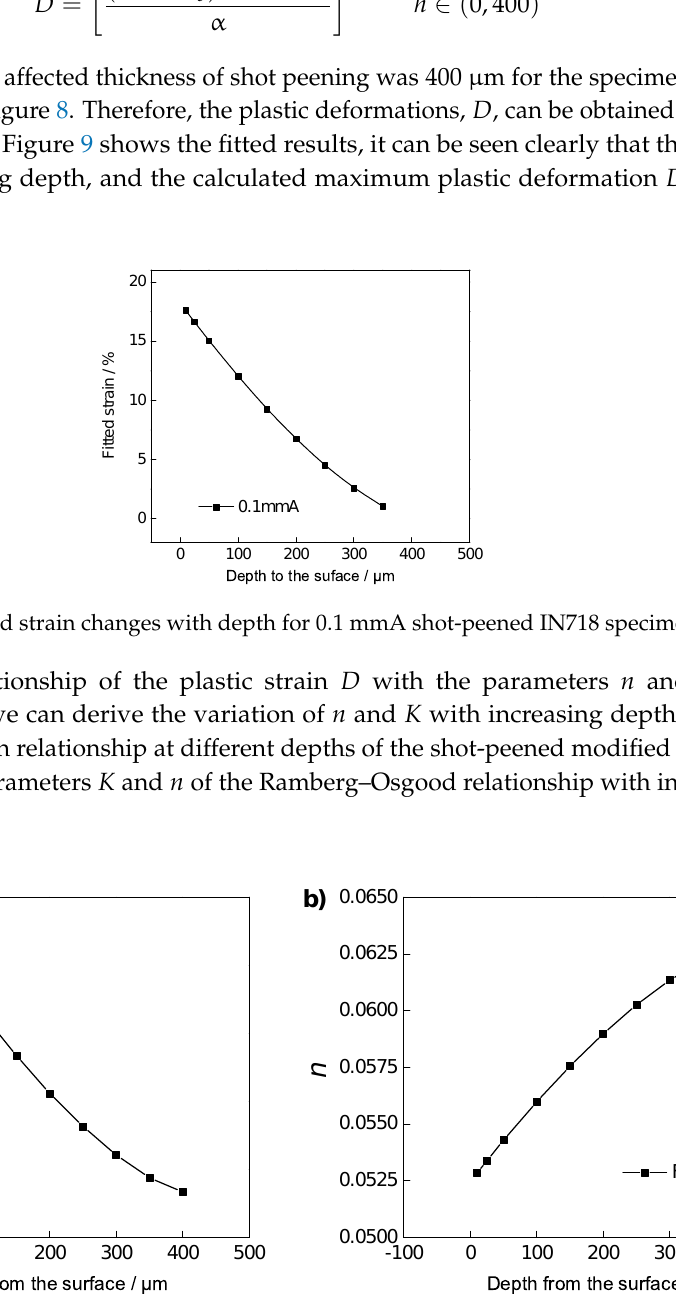
Figure 10. Parameters K and n changing with depth for 0.1 mmA shot-peened IN718 specimens. ( a ) The fitted distribution of K with depth. ( b ) The fitted distribution of n with